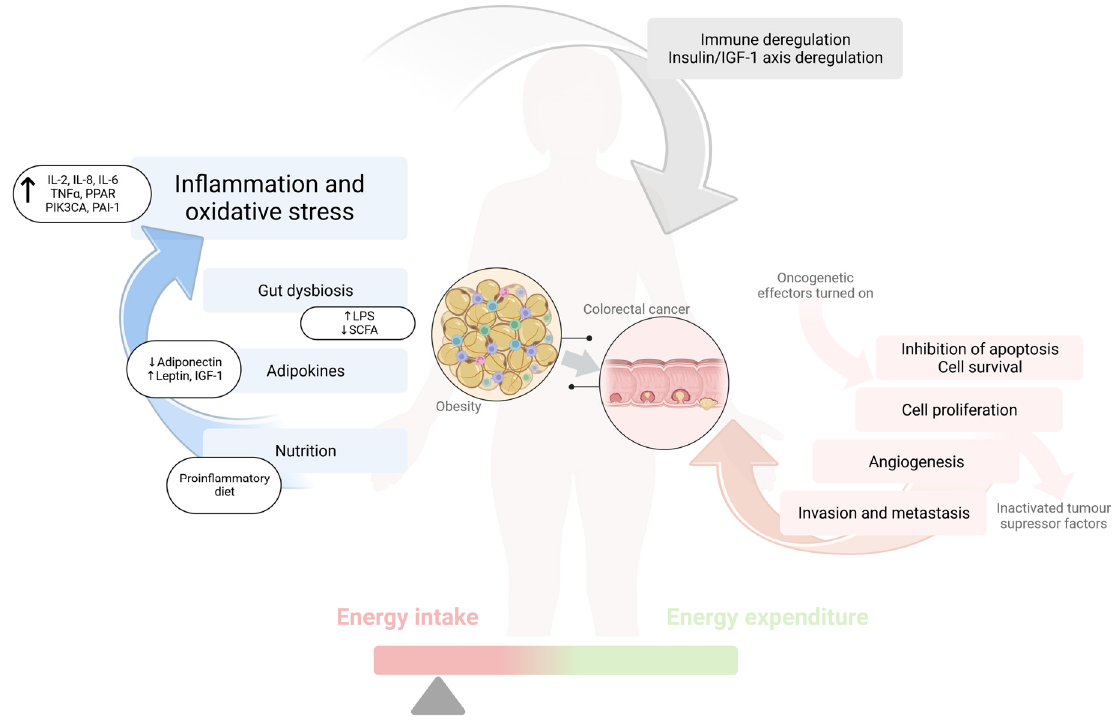
Figure 1. Obesity-related factors and CRC risk.